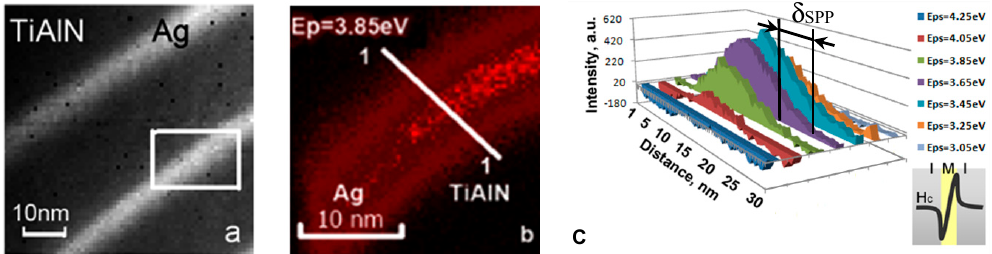
Figure 2. Back scattered image of angle lap of 10/20 Ag/TiAlN coating ( a ); plasmon losses mapping ( Δ E = 3.85 eV) ( b ); distribution of plasmon intensities across line 1-1 in dependence on plasmon energy